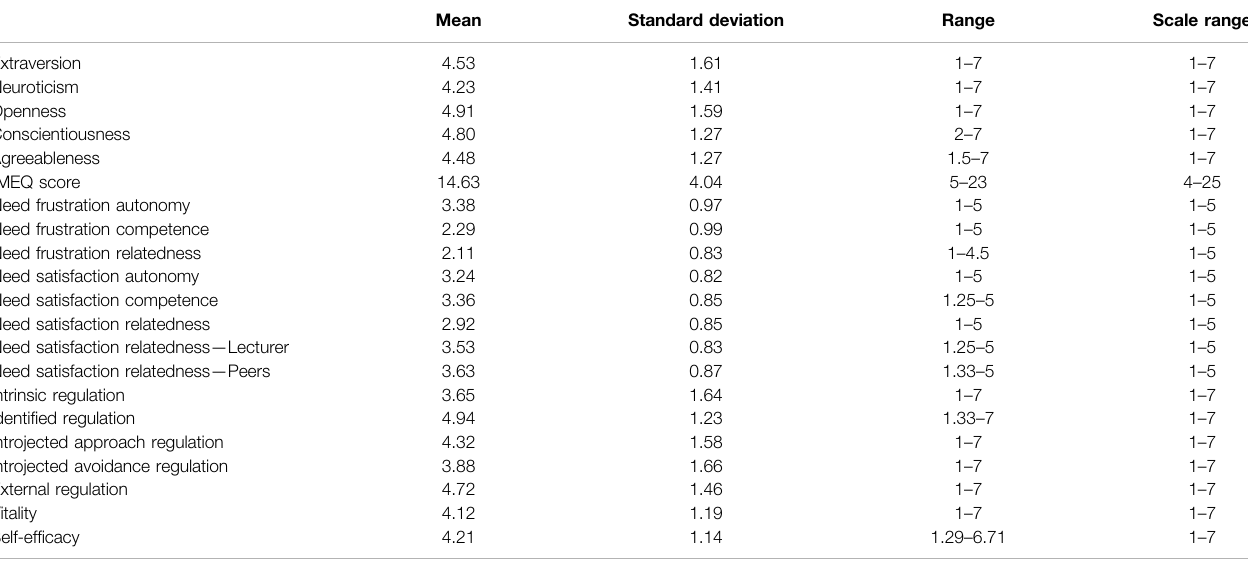
TABLE 1 | Means, standard deviations and ranges of the independent (personality, chronotype) and dependent variables (basic psychological needs, motivational regulation, vitality, self-ef fi cacy).